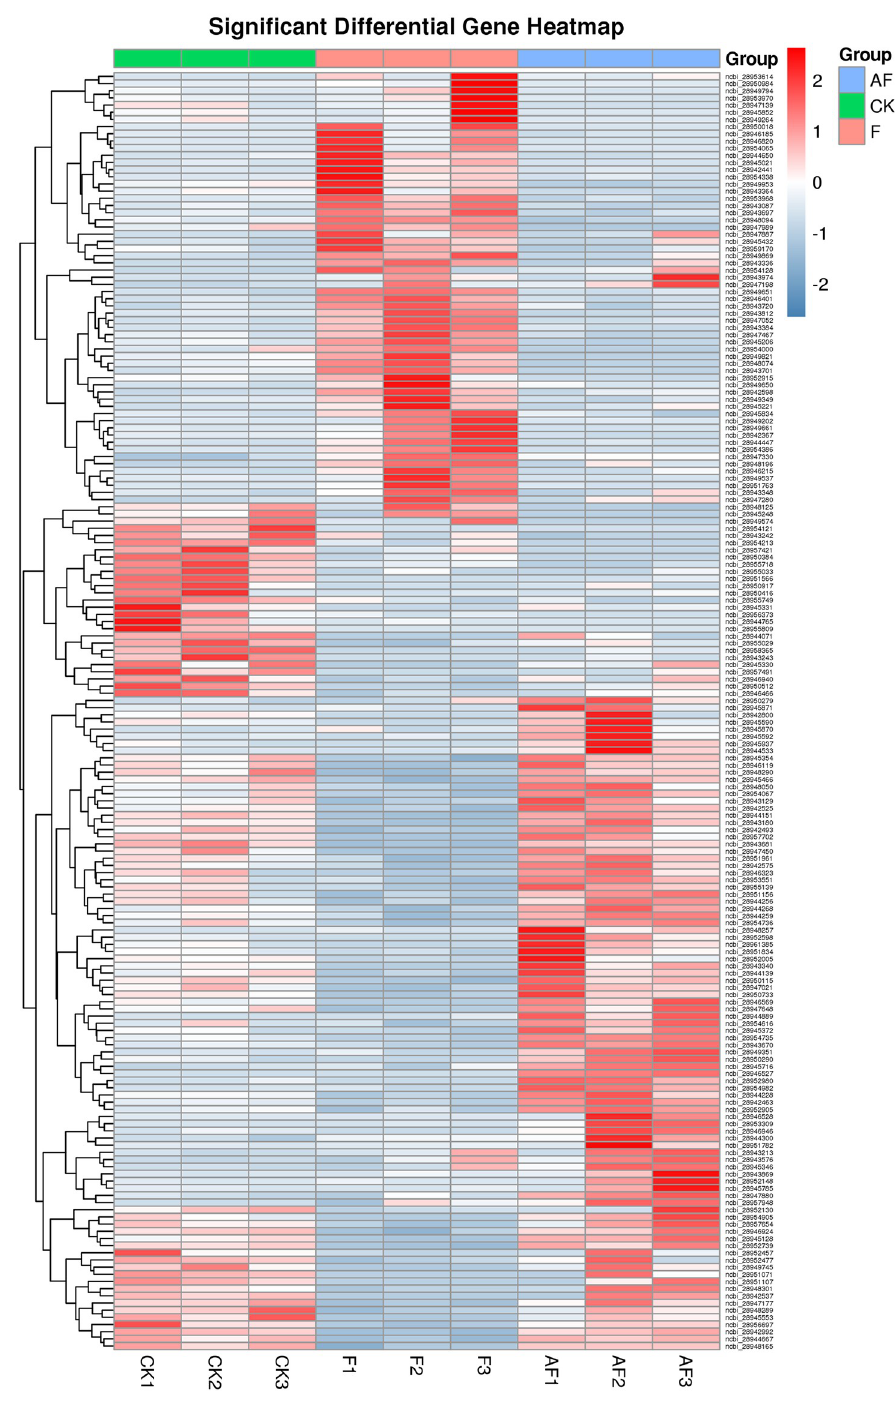
Fig 6. Clustering of differential expression patterns between groups. Based on the amount of gene expression, the hierarchical clustering of the relationship between samples and genes is carried out, and the results of clustering are presented by using heat map. Take 2 as the base to calculate the logarithm value of gene expression of each sample, and carry out hierarchical cluster analysis for different samples and genes. Each column in the figure represents a sample, each row represents a gene, and the expression amount of gene in different samples is expressed in different colors. The redder the color, the higher the expression, and the bluer the color, the lower the expression.